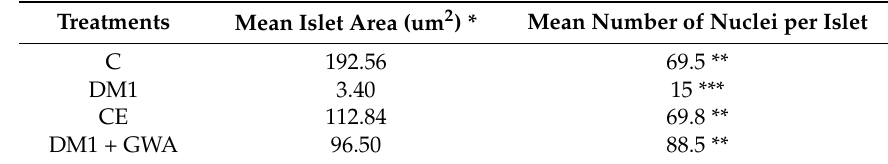
Table 3. Measurements of islets of Langerhans from rats submitted to treatments.